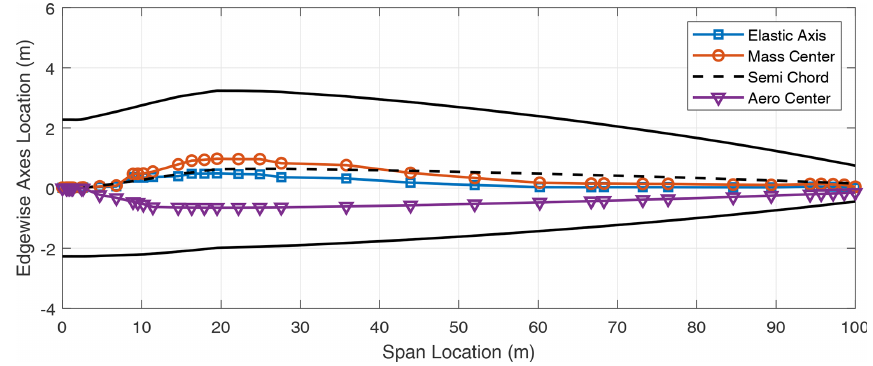
Figure A7. Planform for the SNL100-03 turbine blade.